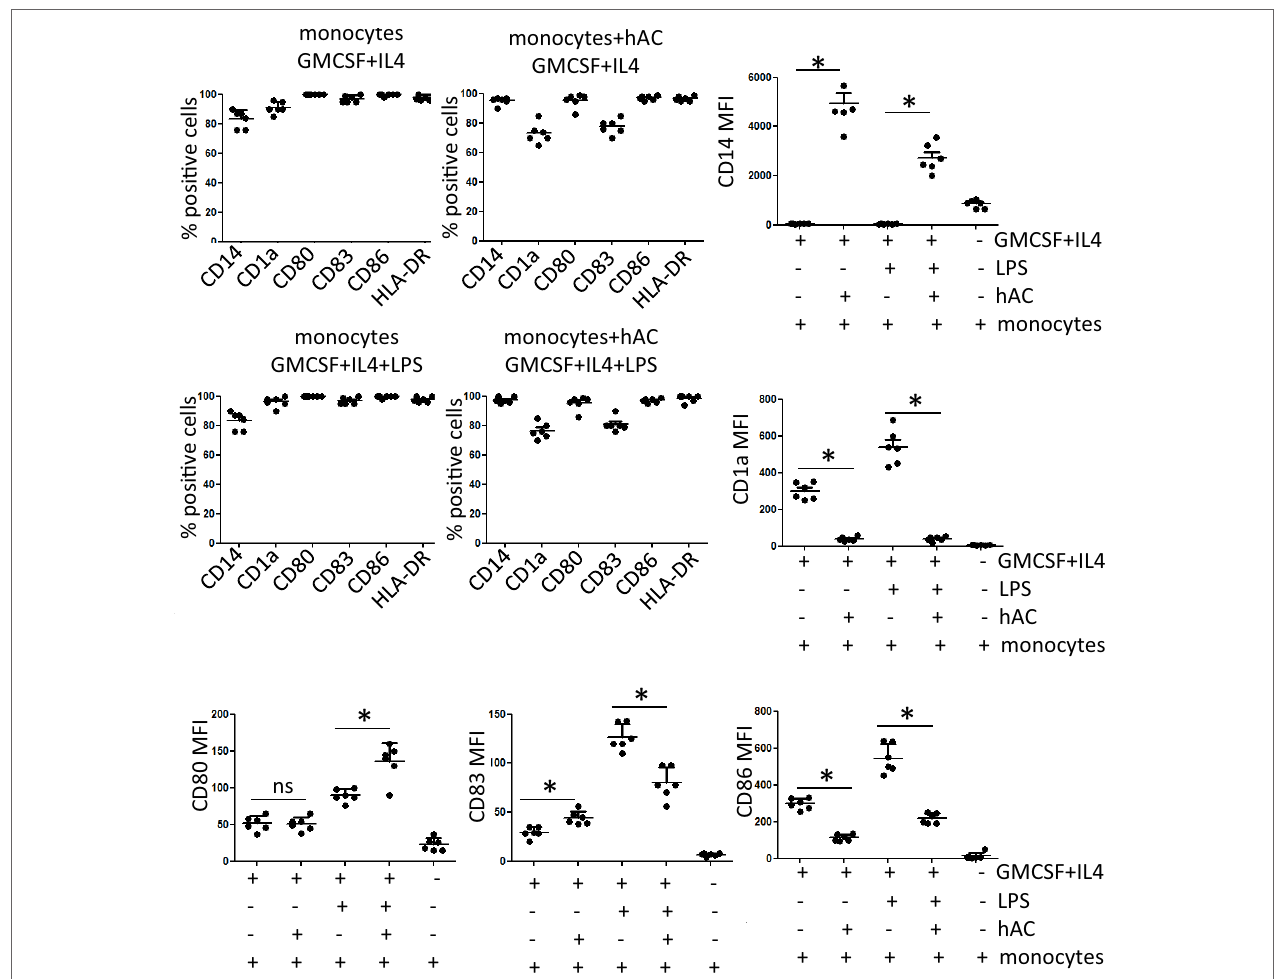
FigUre 4 | expression of differentiation markers of Dc in co-cultures with hac . The percentage of positive cells as well as the mean of fluorescence intensity of each marker indicated is shown from six independent experiments using four different hAC preparations and six healthy donors of Mo. The expression of CD1a, CD14, CD80, CD83, and CD86 was determined after five-color labeling. The expression of HLA-DR was evaluated by indirect immunofluorescence using anti-HLA- DR specific mAb (D1-12) followed by isotype specific PE-conjugated goat anti-mouse. Results are the mean ± SD of six independent experiments. * p <